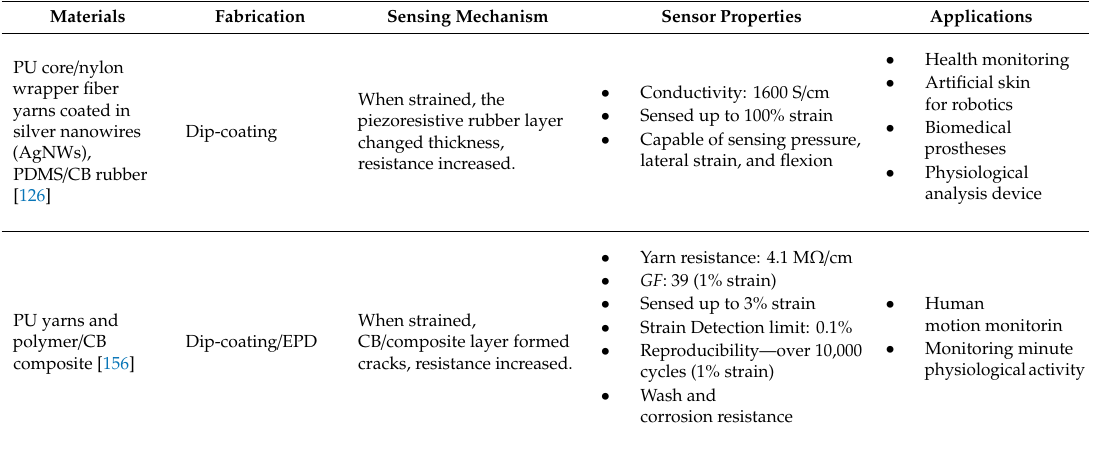
Table 4. Fiber-based strain sensors coated with other carbonaceous